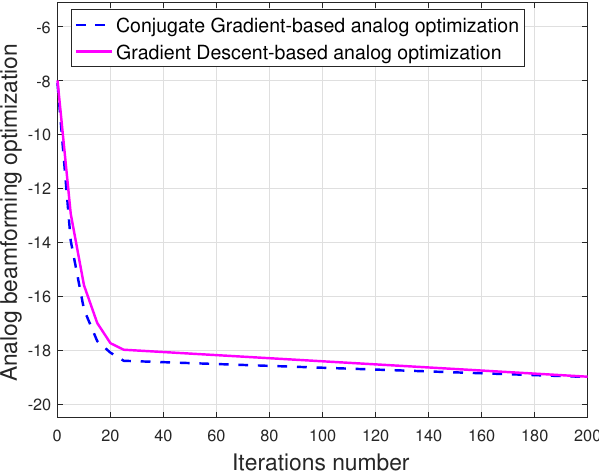
Figure 6. Convergence of the proposed CG algorithm−based analog beamforming optimization.